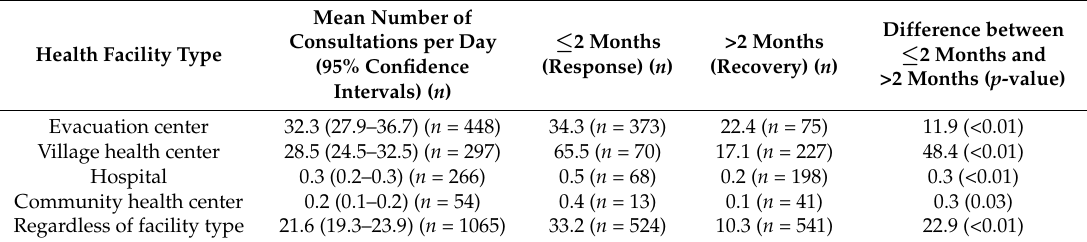
Figure 1. Bar graph of daily number of Surveillance in Post Extreme Emergencies and Disasters (SPEED) reports with spline. Table 1. Total consultation rates per 10,000 individuals for health facility types comparing time post-disaster.